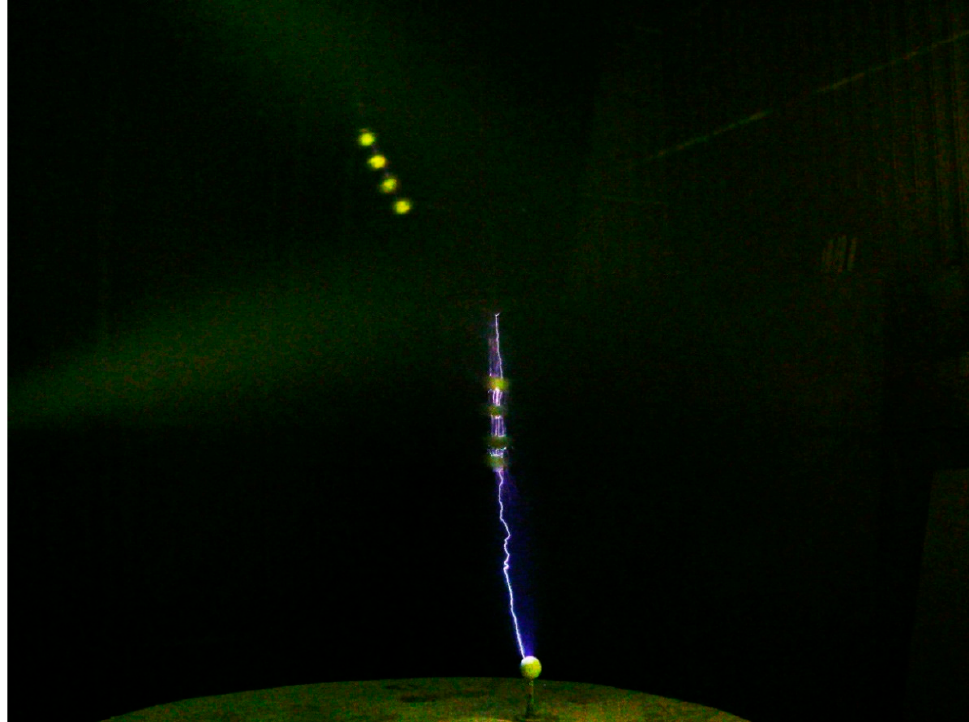
Figure 8. Discharge formation between the system of artificial positively charged thunderstorm cells and the ground involving only the lower group of model hydrometeors.